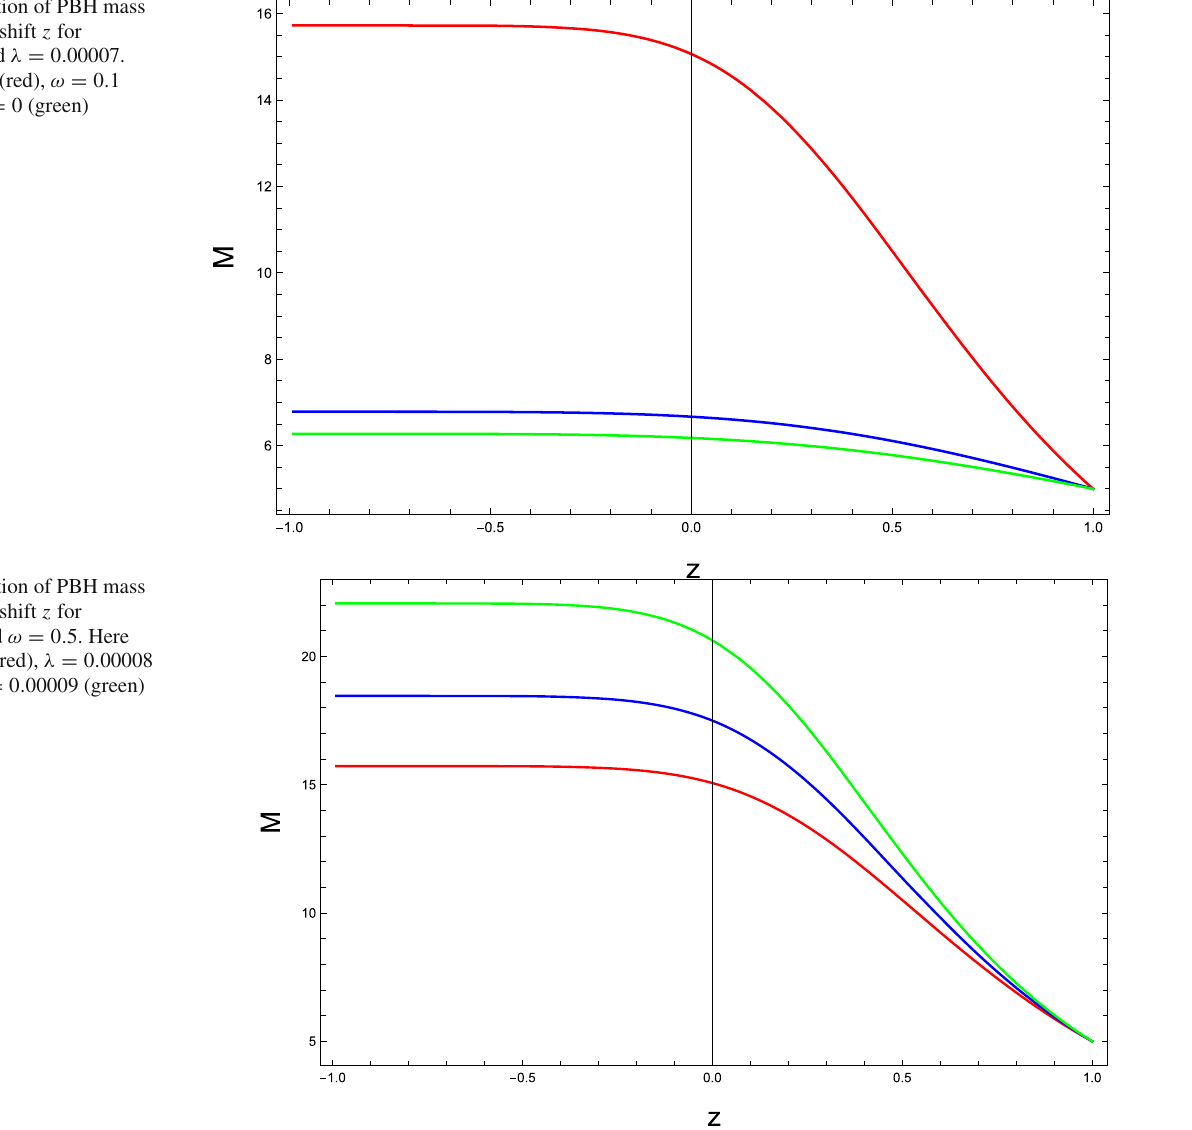
Fig. 1 Evolution of PBH mass M ( z ) with redshift z for different ω and λ = 0 . 00007. Here ω = 0 . 5 (red), ω = 0 . 1